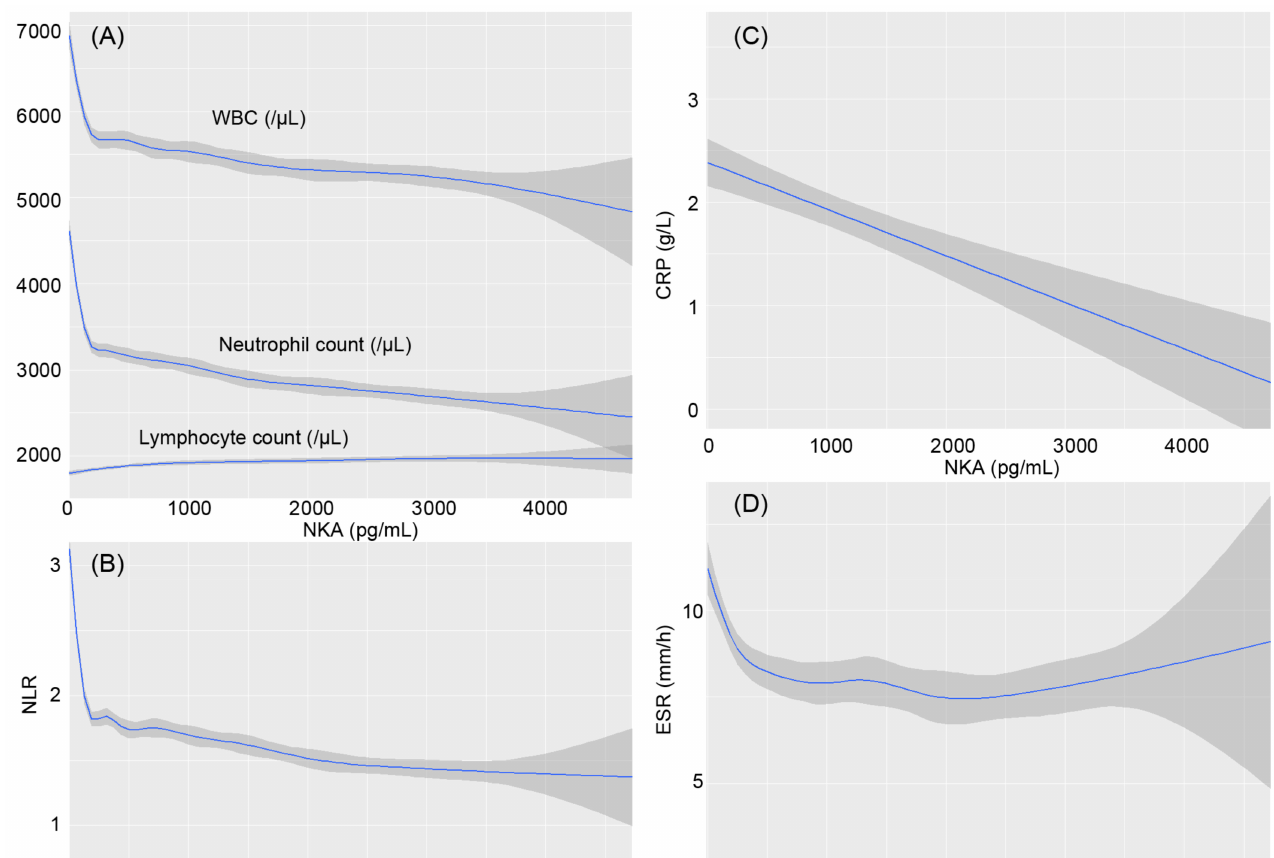
Figure 1. Smoothing splines of the inflammatory indices following natural killer cell activity. NKA, natural killer cell activity; WBC, white blood cell; NLR, neutrophil-to-lymphocyte ratio, CRP, C- reactive protein; ESR, erythrocyte sedimentation rate. The inflammatory indices are ( A ) the parame- ters in complete blood cell counts, ( B ) neutrophil-to-lymphocyte ratio, ( C ) C-reactive protein, and ( D ) erythrocyte sedimentation